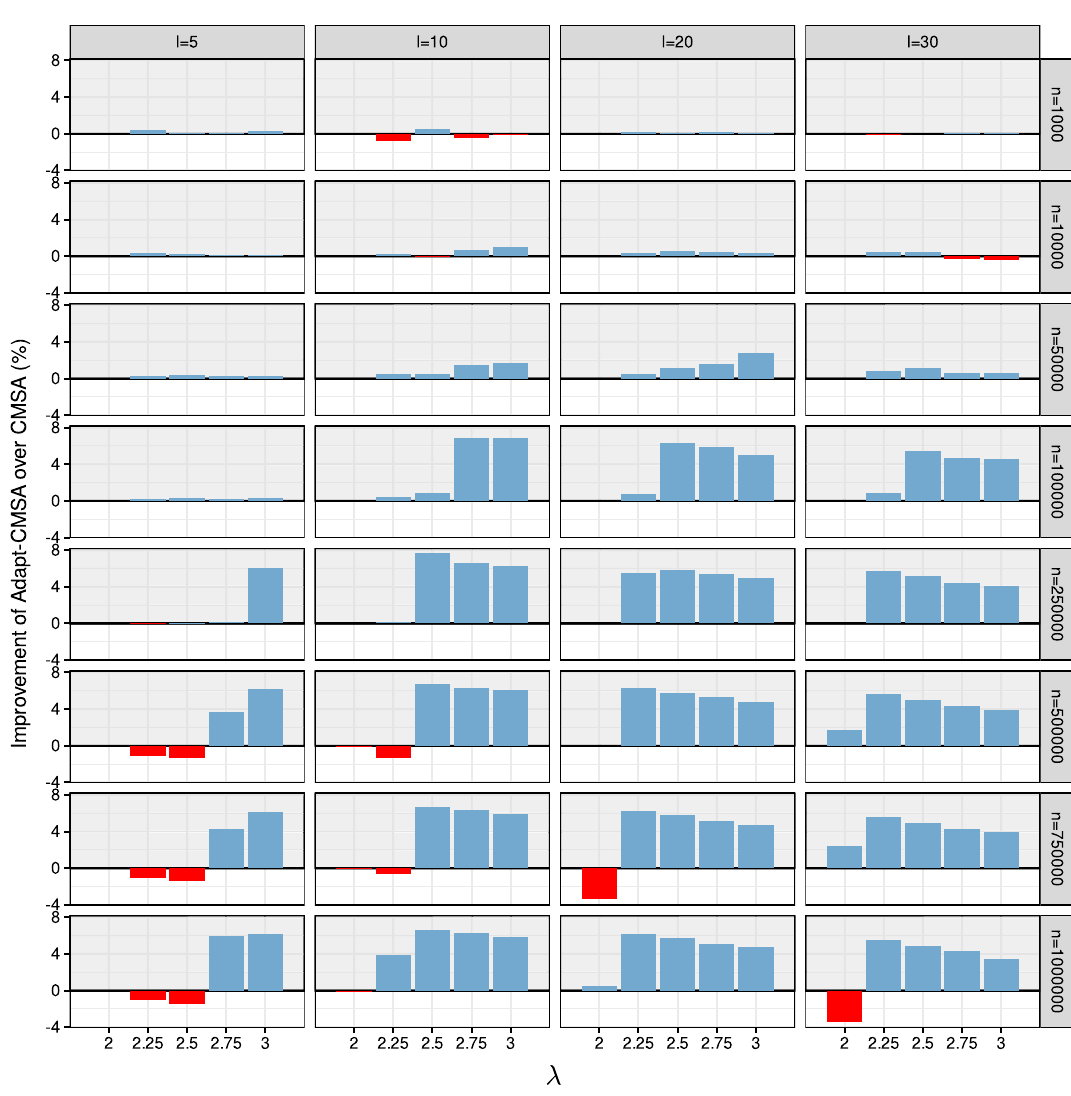
Fig. 1 Average improvement of Adapt-CMSA over standard CMSA (in